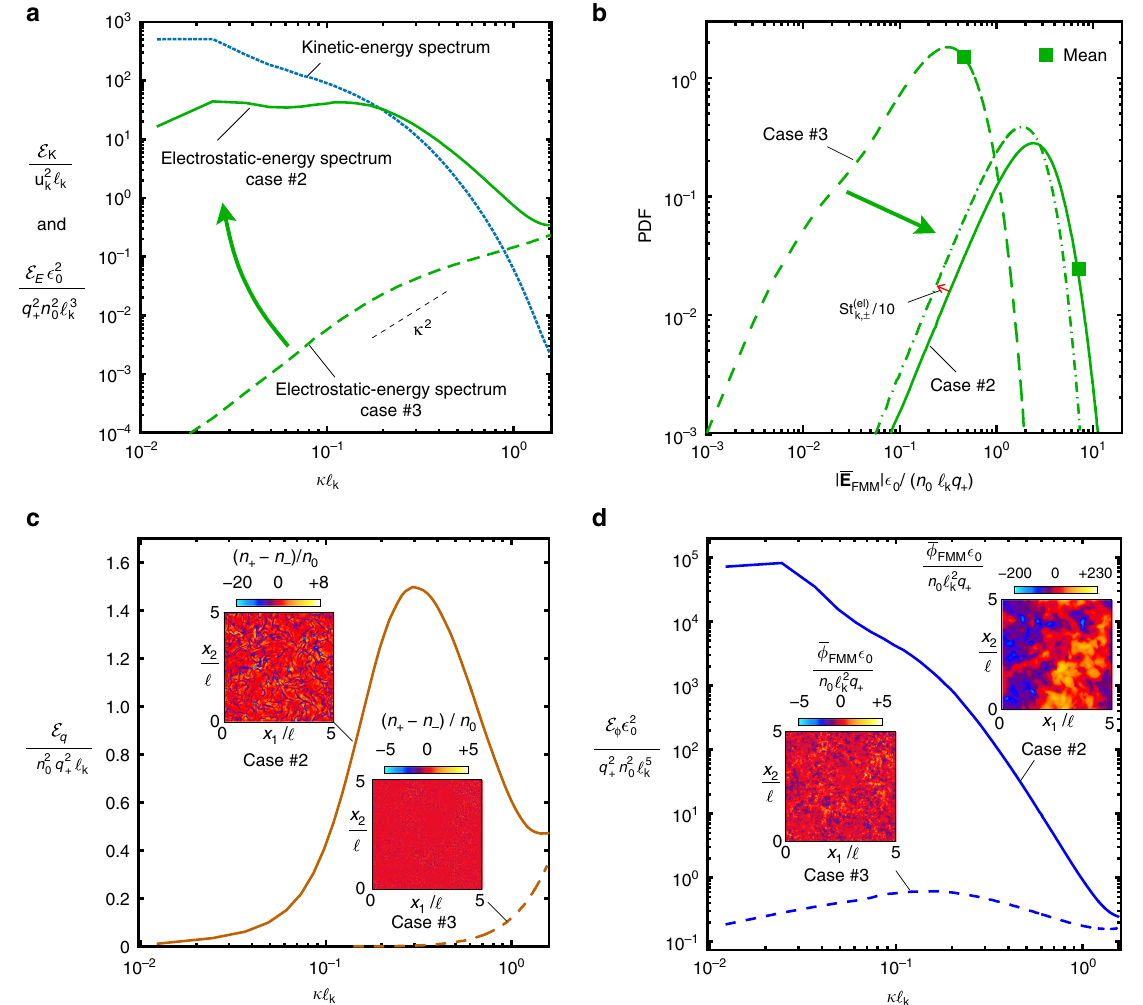
Fig. 5 Effects of the turbulent dispersion of particles on the electric fi eld. a Ensemble-averaged electrostatic and kinetic-energy spectra as a function of the wavenumber. b Ensemble-averaged normalized probability density functions (PDF) of the modulus of the FMM-derived mesoscopic electric fi eld (case #2 mean: 7.3, case #2 95th percentile: 13.6; case #3 mean: 0.4, case #3 95th percentile: 0.9). c Ensemble-averaged energy spectra of the net charge-density fl uctuations as a function of the wavenumber, including instantaneous cross-sectional contours (insets). d Ensemble-averaged energy spectra of the electric-potential fl uctuations as a function of the wavenumber, including instantaneous cross-sectional contours